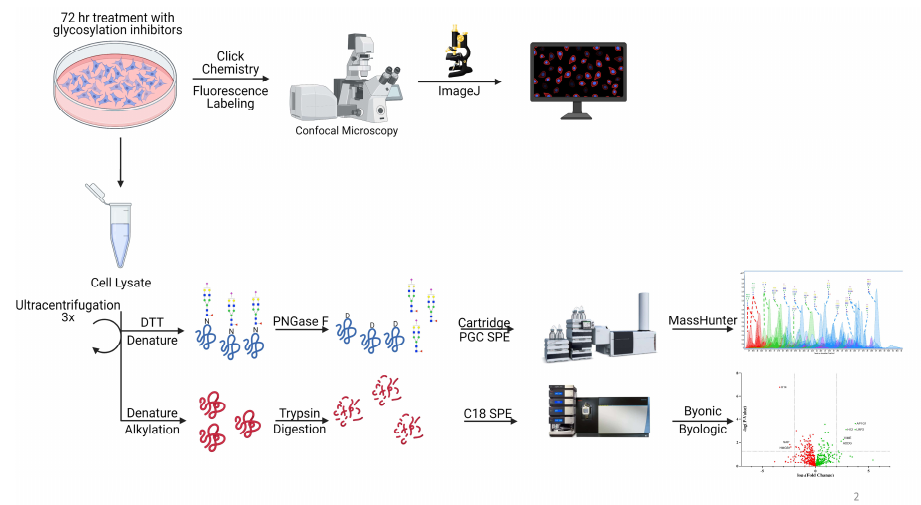
Figure 1. The schematic workflow for characterization of N -glycomics, proteomics, and confocal microscopy. Glycosylation inhibitors were added to the supernatant and treated for 72 h followed by cell membrane extraction and analysis. Click chemistry was performed after 72 h of treatment followed by imaging to determine 6-alkynyl fucose (6AF) incorporation. Schematic workflow was created with BioRender.com last accessed 17 August 2021.